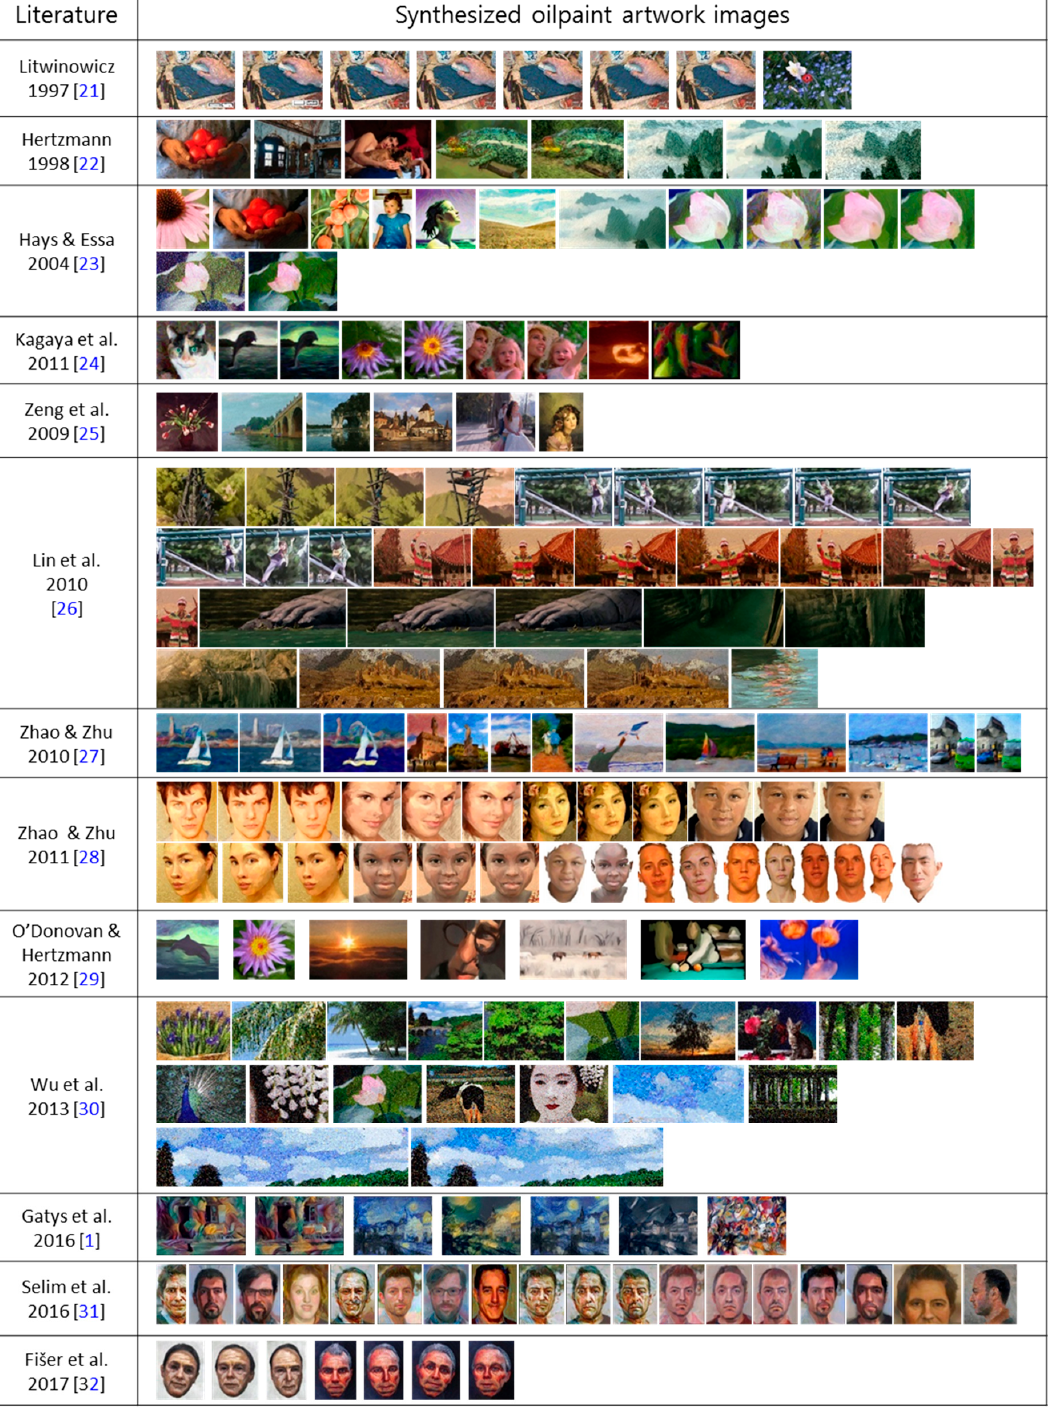
Figure 14. Oil paint images in SynthSet . Figure A1. Oil paint images in SynthSet